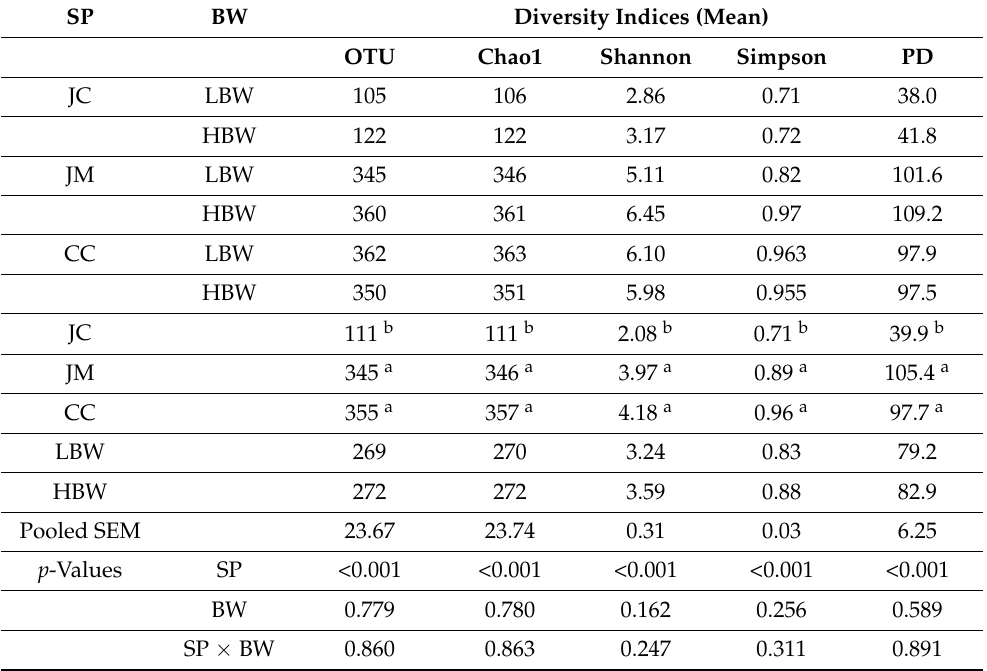
Table 1. Diversity indices of the intestinal microbiota of broiler chickens. SP BW Diversity Indices (Mean) OTU Chao1 Shannon